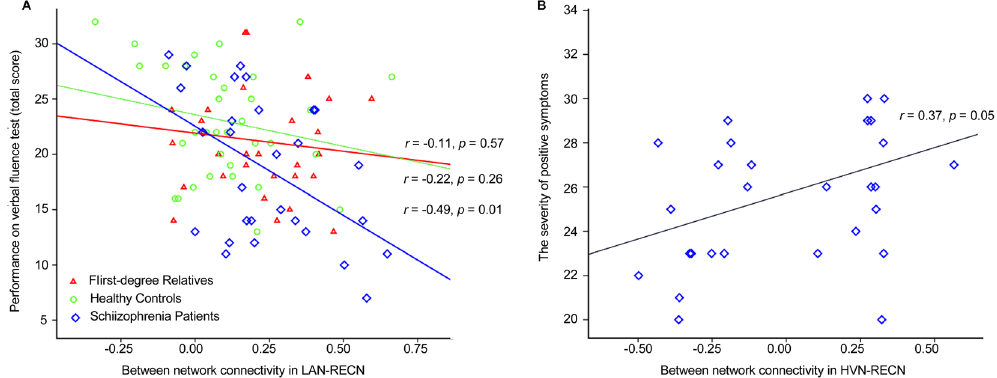
Figure 4. Relationship between internetwork connectivity measures and clinical and cognitive variables. ( A ) Correlation between connectivity between the language and executive control networks and language processing performance. ( B ) Correlation between connectivity between the high-visual network and executive control networks and severity of positive symptoms. RECN, right executive control network; LAN, language network; HVN, high-visual